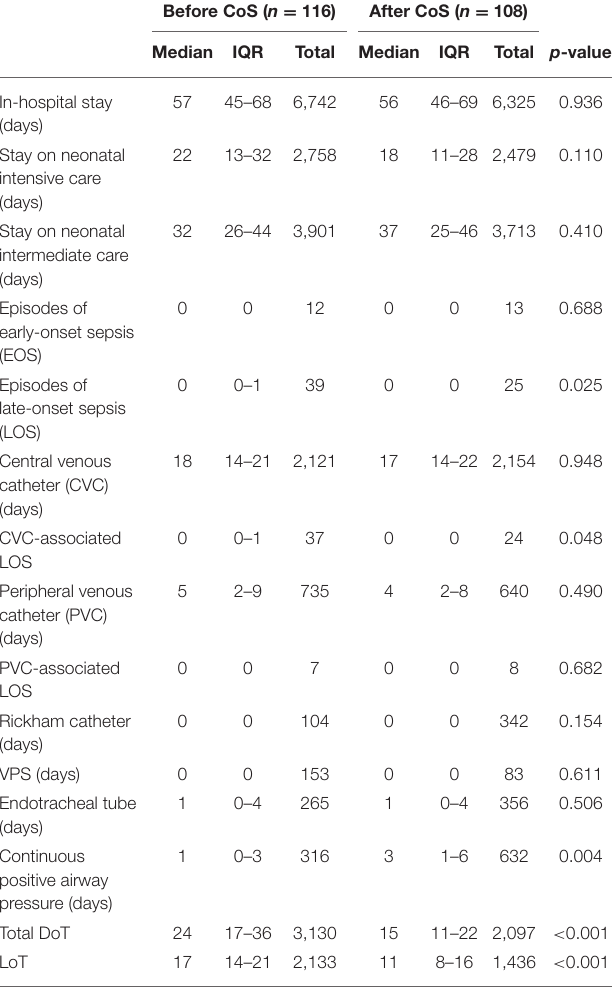
TABLE 5 | Comparison of of nosocomial infections, use of devices, length of therapy (LoT), and total days of therapy (DoT) between the two cohorts before and after the introduction of colonization screening (CoS), limited to the birth weight category of 1,000–1,499g.